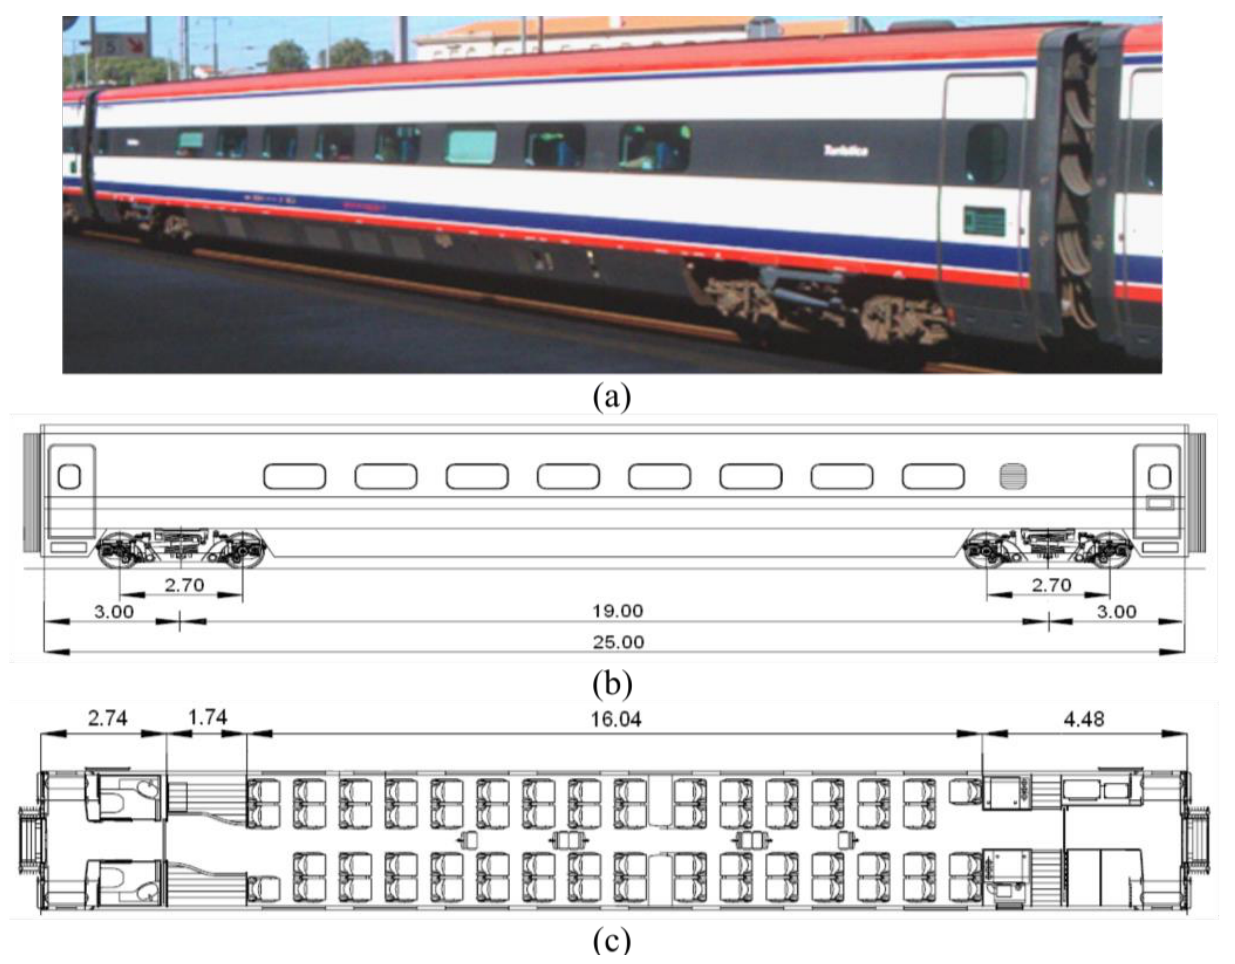
Figure 1. BBN vehicle: ( a ) perspective; ( b ) elevation; ( c ) floor plan.